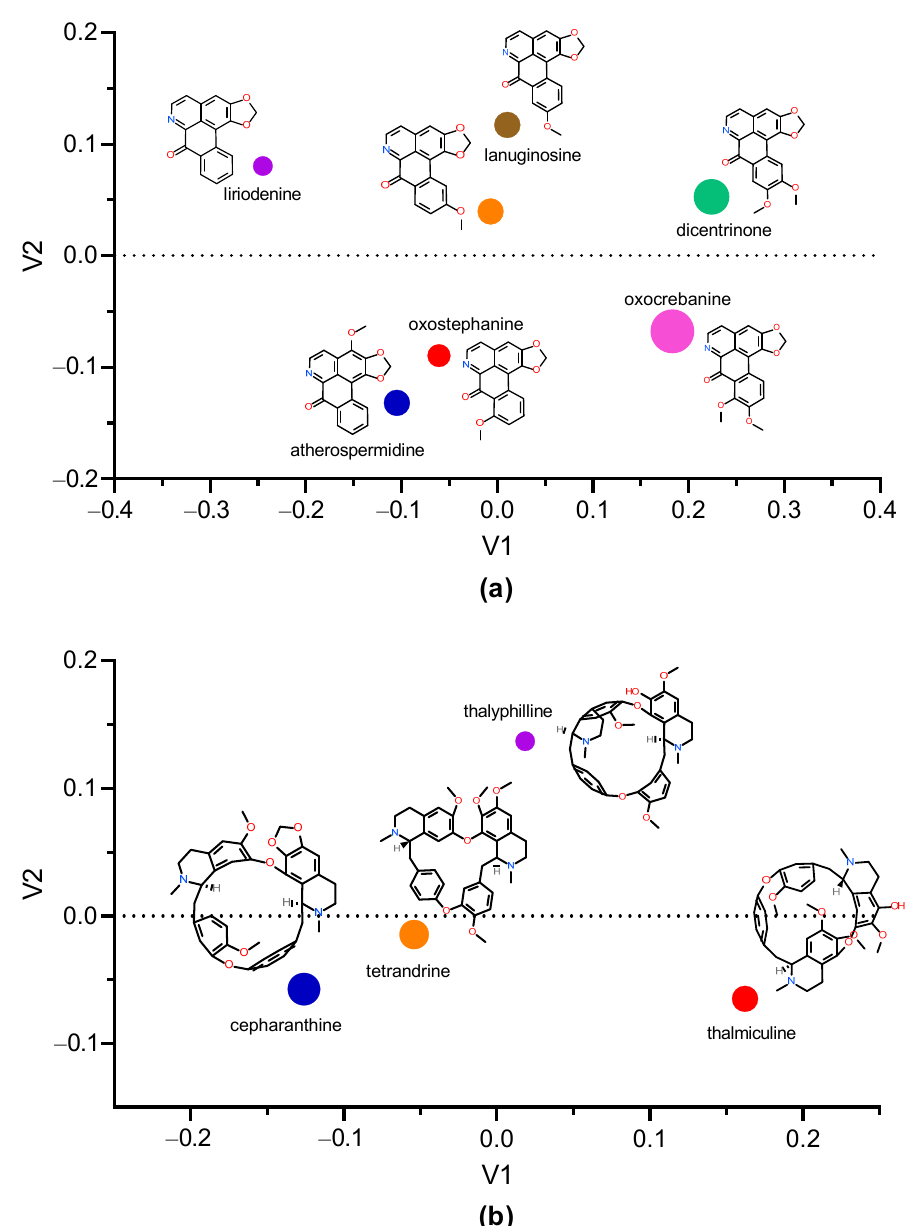
Figure 8. Multidimension scaling analysis using Tanimoto coefficient. The multidimension scaling analysis of structural similarity among selected IAs was performed with ChemMine tools [32]. ( a ) Clustering of oxostepharnine, liriodenine, lauterine, atherospermidine, lanuginosine, oxocrebanine, and dicentrinone. ( b ) Comparison of structures of thaliphylline and thalmiculine and the inhibitory effects of oxostephanine, thaliphylline, thalmiculine, tetrandrine, and cepharanthine versus KCl concentrations. Inside the graphs, the 2D structure of each IA is shown next to the corresponding colored dot, whose size is proportional to the molecular weight. V1 and V2 values were calculated using Tanimoto coefficient.